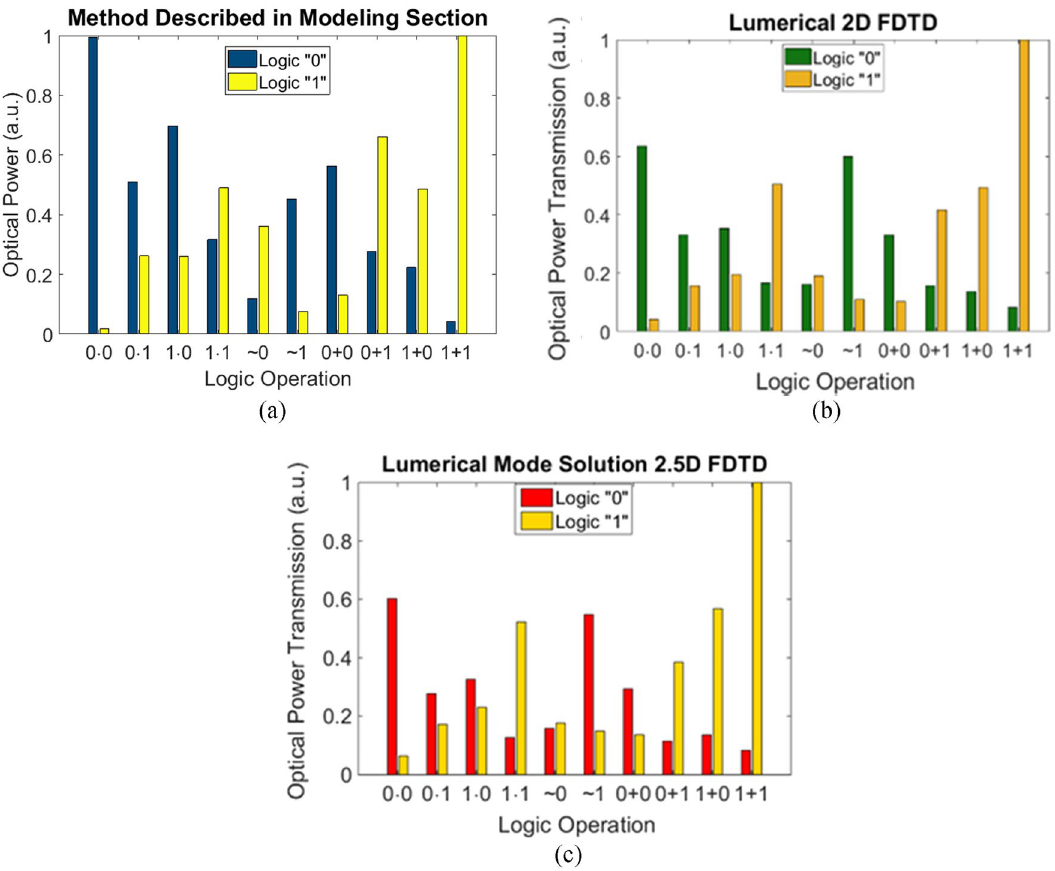
Figure 5. The logic operation of the numerically-trained diffractive model with five diffractive layers, ( a ) numerical results, ( b ) Lumerical 2D FDTD results, and ( c ) Lumerical Mode Solution 2.5D FDTD simulation